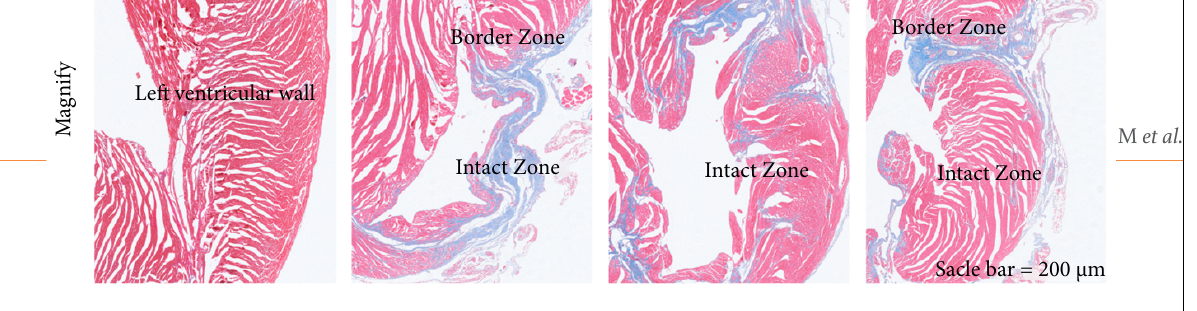
Figure 3 - Representative pictures for infarct by Masson staining in mice heart. (a-d) Masson staining in the coronal section of mice heart. Scale bar: 1 mm, magnification 1.25×. The black box area is enlarged in the lower panel; (e-h) Enlarged view of the black box area in a-d, respectively. Scale bar: 200 μ m, magnification 5×. After administration of jatrorrhizine, the infarct area is significantly